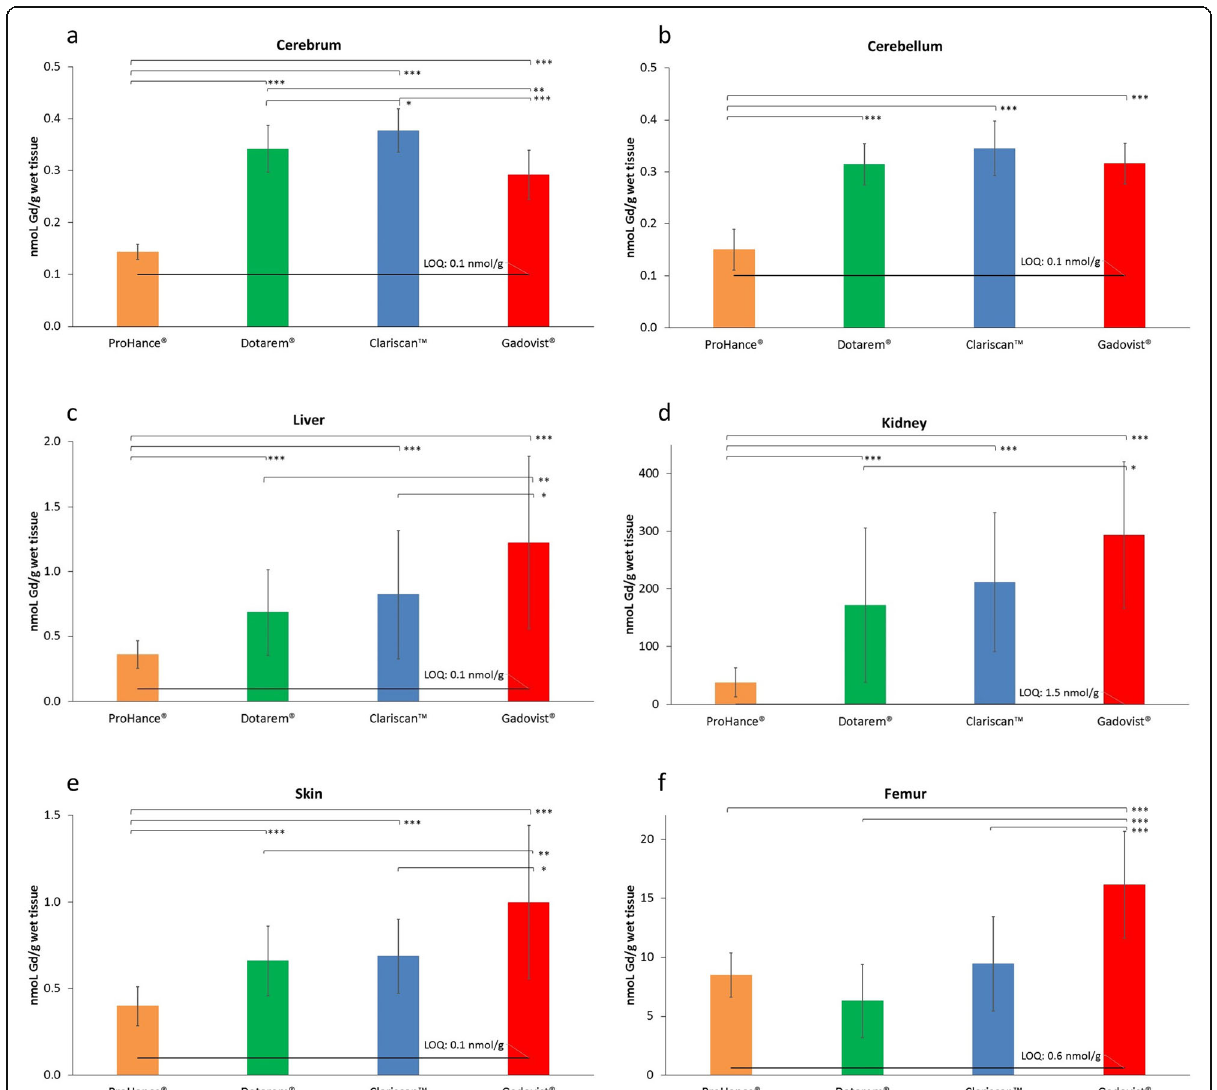
Fig. 1 Gadolinium content in the ( a ) cerebrum, ( b ) cerebellum, ( c ) liver, ( d ) kidney, ( e ) skin, and ( f ) femur: Mean values ± SD. The significance of differences between groups is shown as * p ≤ 0.05, ** p ≤ 0.01, and *** p ≤ 0.005. Data for blood and for the control group (group A, saline) are not shown because all values were below the LOQ. The error bars represent the standard deviation of measurements within the groups ( n = 15, except “ Dotarem, skin ” and “ Gadovist, kidney ” where n =